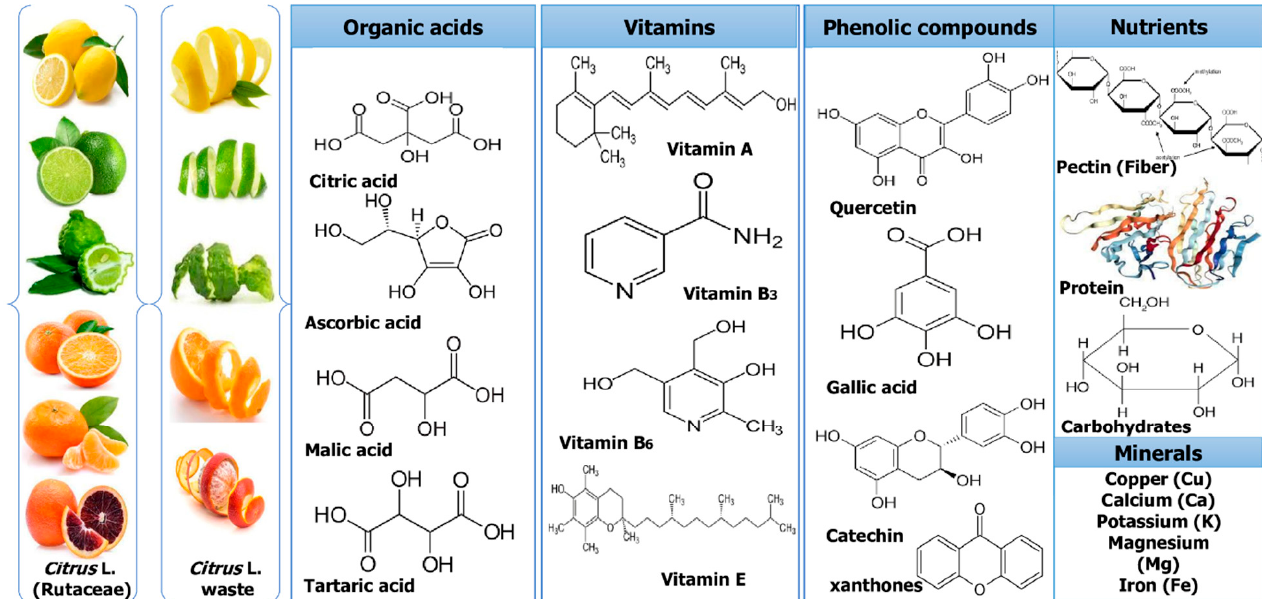
Figure 2. Major phytochemicals of Citrus L. waste. Table 1. Compositions and potential food applications of citrus